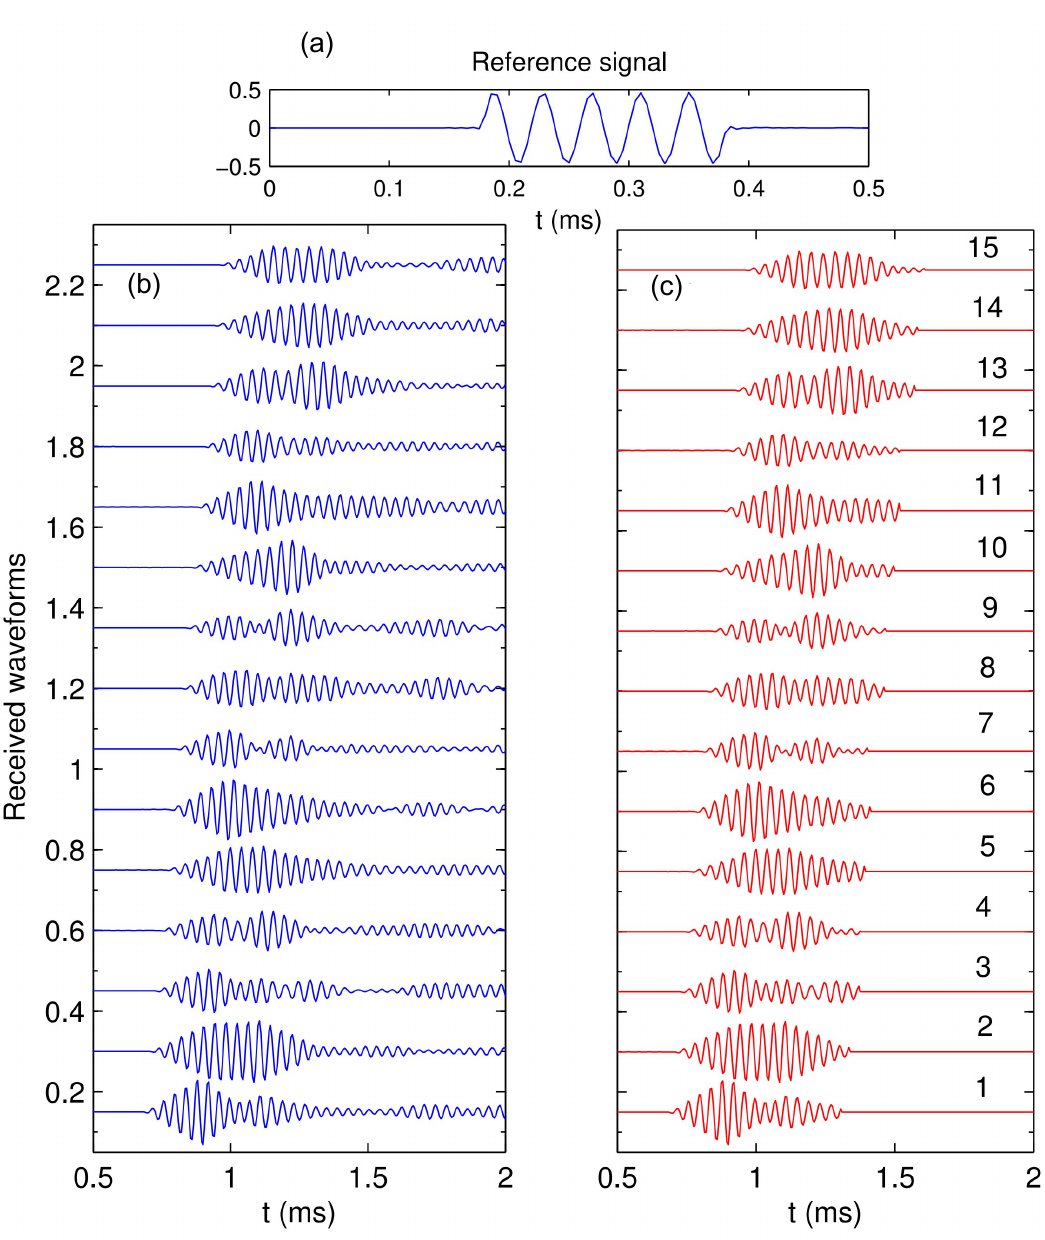
Figure 2. Received waveforms by the receiving array1 of 15 hydrophones located at z = z 1 , where sound waves are incident at an grazing angle θ g = 30 ◦ relative to the surface of sand bottom and frequency f = 24.57 kHz. ( a ) reference signal for a measurement with a horizontal array of five hydrophones at z = z 1 ; ( b ) received waveforms (temporal correlation between the received sound pressure and the corresponding reference signal); ( c ) the truncated waveforms adopted for beam- forming are marked by numbers from n = 1 to n =